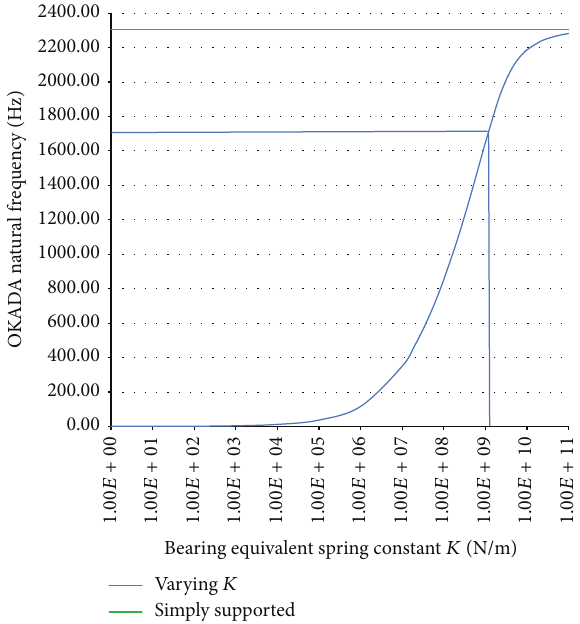
Figure 8: System fundamental frequency versus bearing equivalent spring constant for a low speed spindle (in log scale).